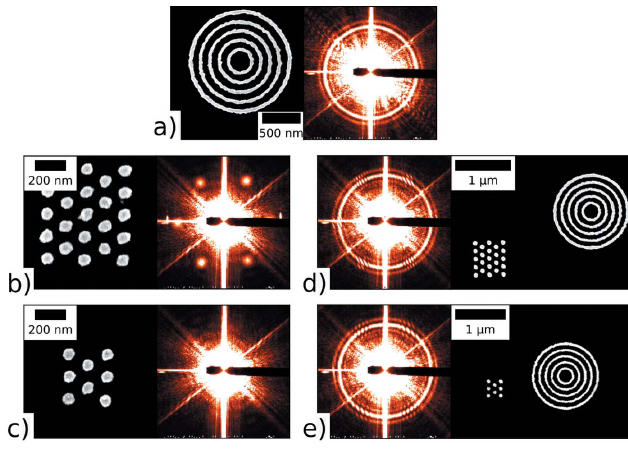
Figure 2 SEM images and SAXS data for a selection of meso-structures. ( a ) A pattern of concentric rings generates a strong isotropic ring of scattering; this structure is used as an amplifier. ( b ) A 5 (cid:11) 5 hexagonal arrangement of 23 dots, fabricated as a test sample. ( c ) A 3 (cid:11) 3 hexagonal arrangement of 8 dots, which acts as a very weakly scattering sample. ( d ) When there is coherent interference between a sample and the amplifier (in this example, by patterning them side by side on a single substrate), fringes appear in the scattering pattern, wherever both sample and amplifier scatter strongly. ( e ) In the case of a very weakly scattering sample (which cannot be discerned above the experimental background), coherent interference with the amplifier nevertheless generates a visible fringe pattern. In other words, although the sample alone cannot be resolved, coherent amplification can be used to infer the sample’s scattering